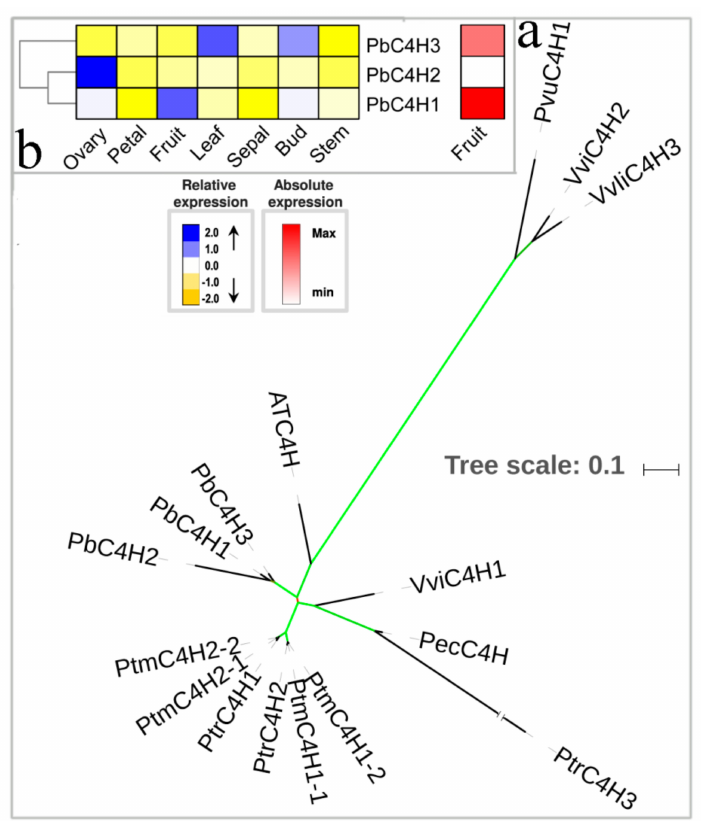
Figure 2. Phylogenetic tree and expression profiles of the C4H bona fide clade. ( a ) ML tree built with C4H bona fide enzymes from several species. ( b ) The expression profiles P. bretschneideri C4H bona fide genes. The green color of the tree branches suggests strong node support (bootstrap support ≥ Table S3. The gene accession number is indicated in Table S4. The tree scale is the number of amino acid substitution per